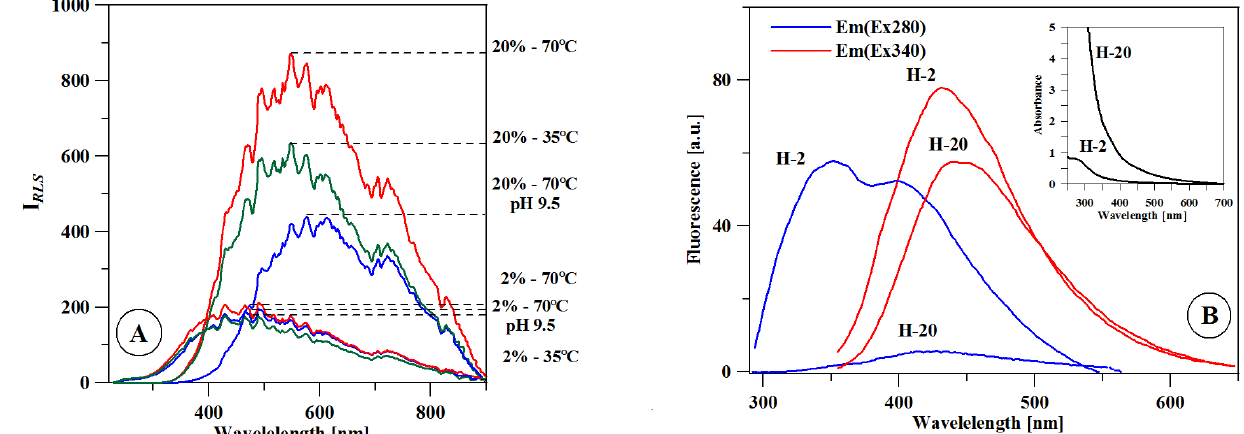
Figure 2. ( A ) Resonance light scattering (RLS) spectra of pure honey in different temperature, concentration, and pH conditions. ( B ) Fluorescence emission spectra of honey at the 2% and 20% concentrations. Inset: Electronic absorption spectra for analogical samples.